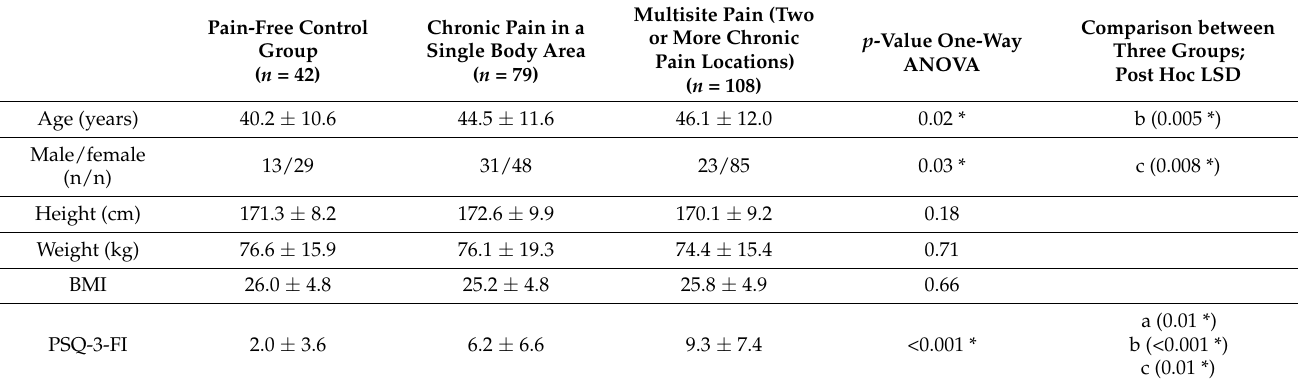
Table 4. Demographics and discriminative validity of the PSQ-3 among the three subgroups ( n =